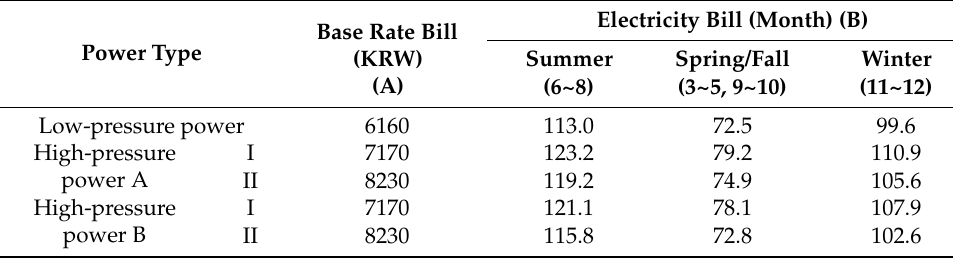
Table 6. Standard Electricity Charge for General Use (Won/kwh) [34].